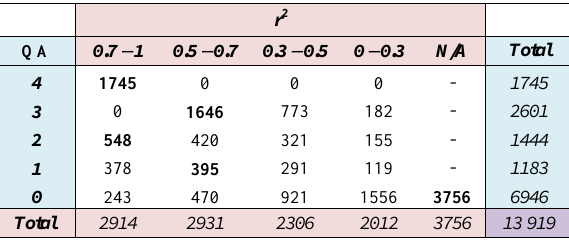
Table 4. The distribution of FEER.v1 C e product QA flags among different coefficients of determination ( r 2 ) ranges. The “N/A” category is for the 1°×1° grid cells that have been filled in using the gap-filling process due to lack of sufficient data (and therefore lack an r 2 value). The r 2 range containing the most grid cells is shown in boldface type for each QA flag.